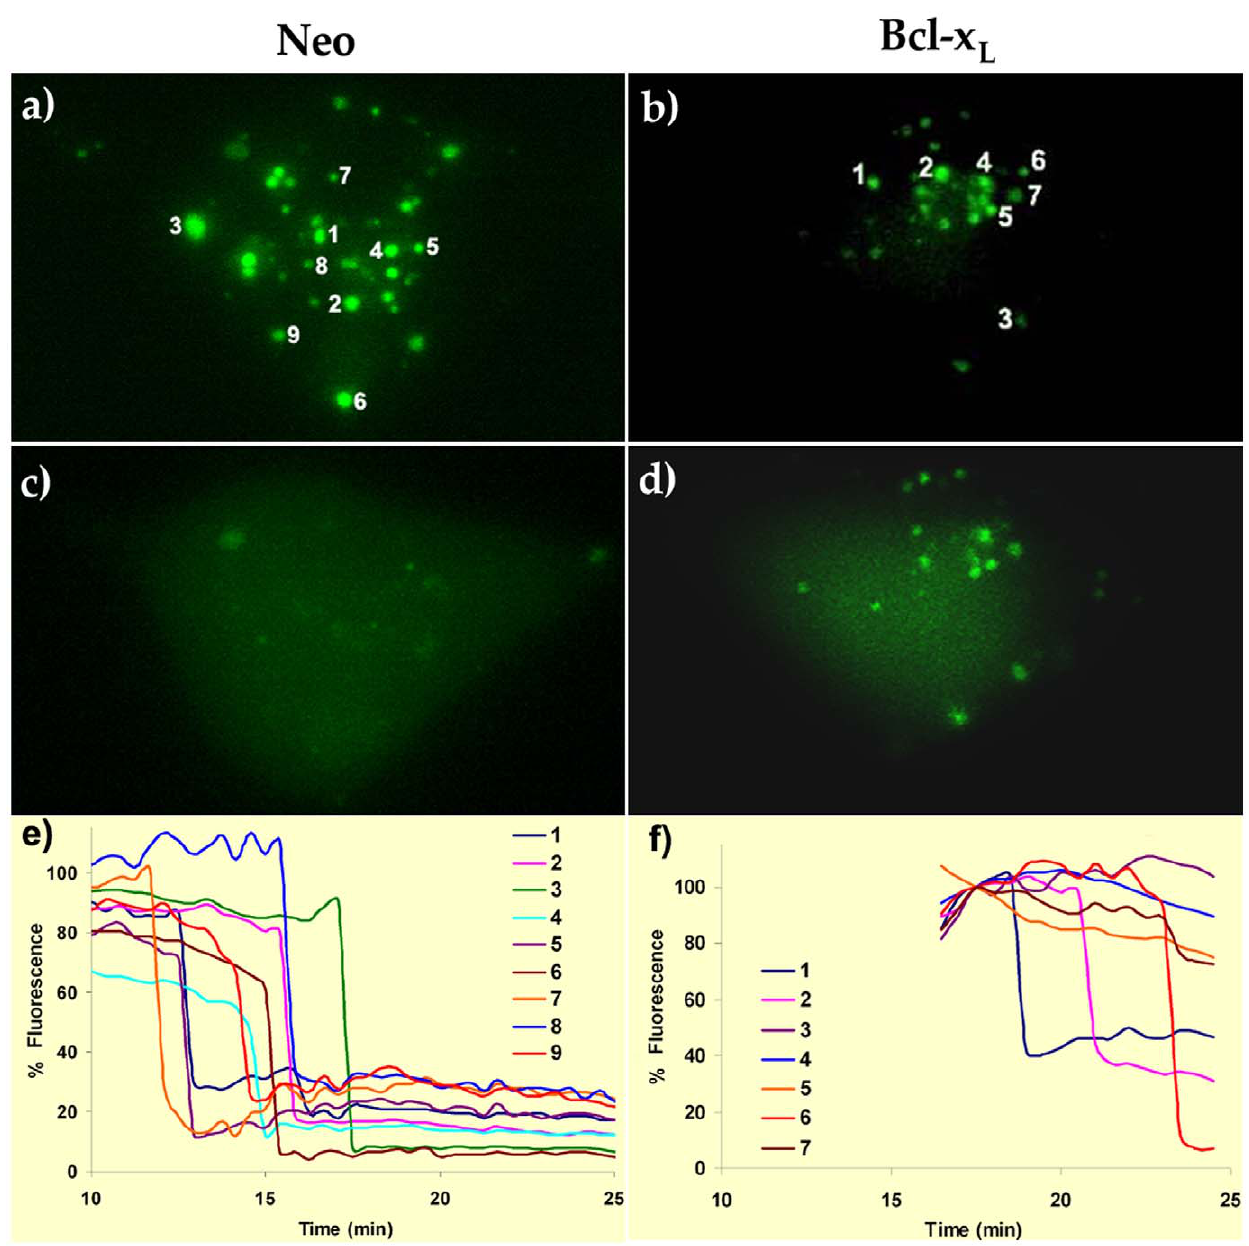
Figure 6. Bcl-x L decreases ionomycin-induced MIMP . SH-SY5Y cells were loaded with calcein as indicated in Material and Methods. Calcein fluorescence in SH-SY5Y/Neo (a and c) and SH-SY5Y/Bcl-x L (b y d) cells exposed to 2 m M ionomycin at time 0 h. a) and b) time =0; c) and d) time = 20 min. Numbers represent individual mitochondrion whose time-course is represented in panels e) and f). Time-course of fluorescent changes in individual mitochondrion from e) SH-SY5Y/Neo and f) SH-SY5Y/Bcl-x L . The complete videos for these experiments can be found in Supporting information Video S3 and Video S4.